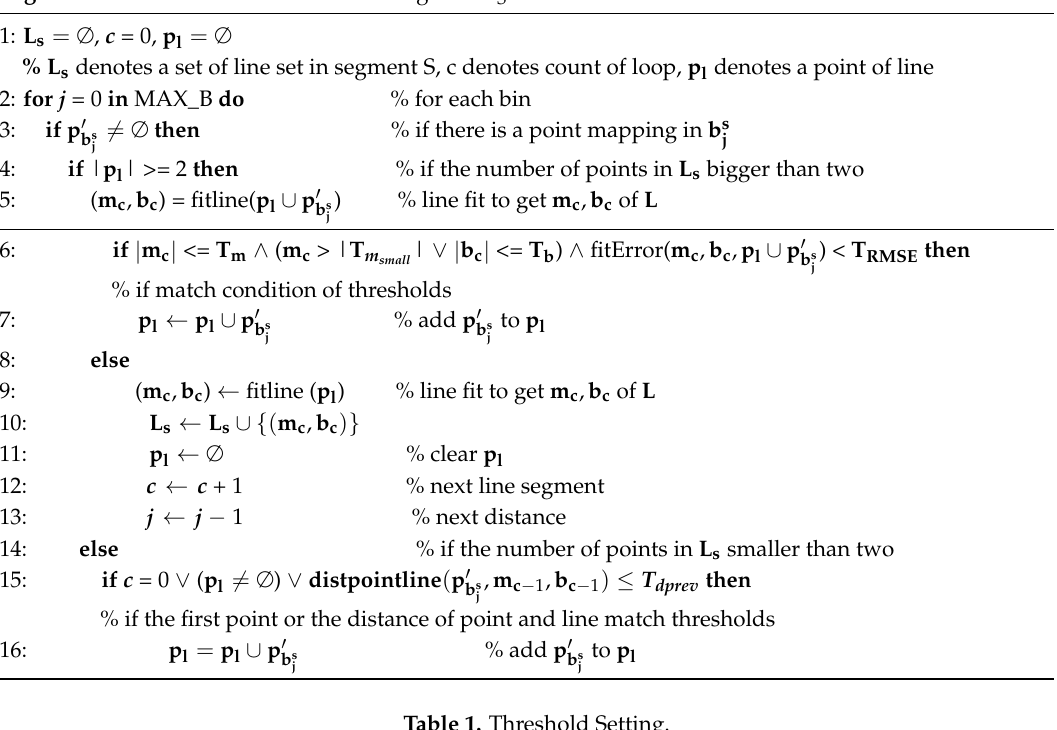
Table 1. Threshold Setting.